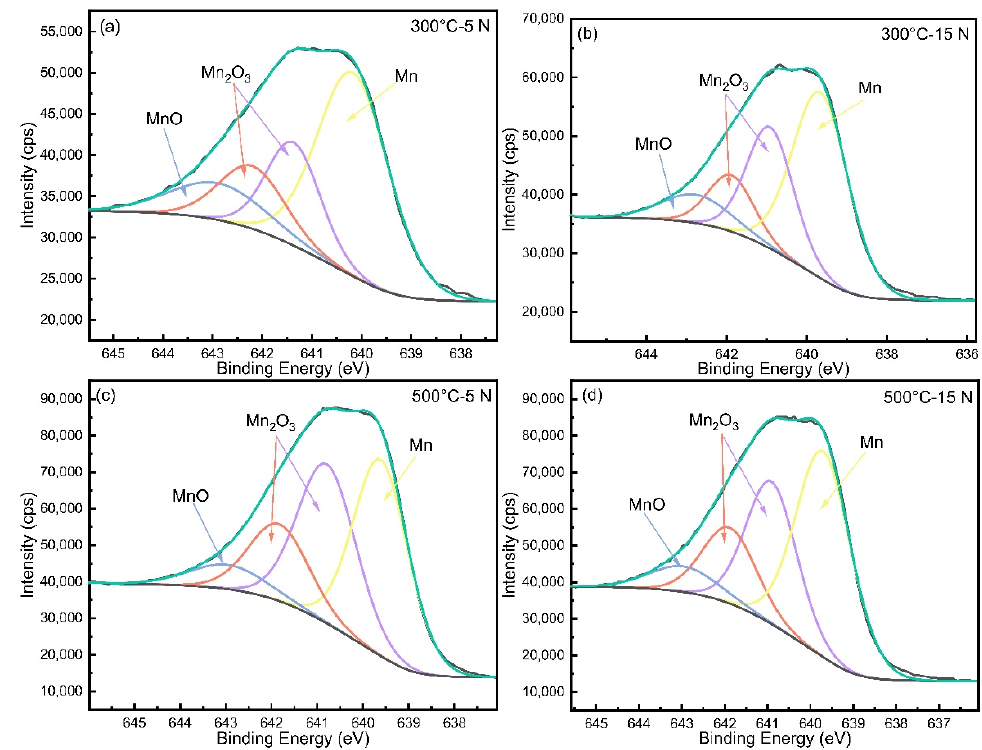
Figure 9. Mn 2p spectra of wear tracks under different conditions. ( a ) 300 °C–5 N, ( b ) 300 °C–15 N, ( c ) 500 °C–5 N, and ( d ) 500 °C–15 N.